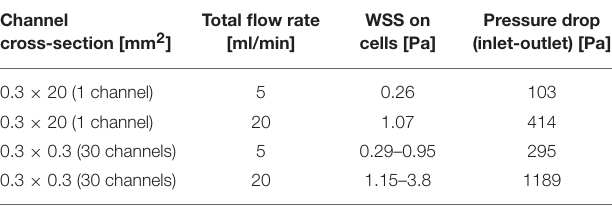
TABLE 2 | Calculated WSS and pressure drop across the flow chamber. Channel cross-section [mm 2